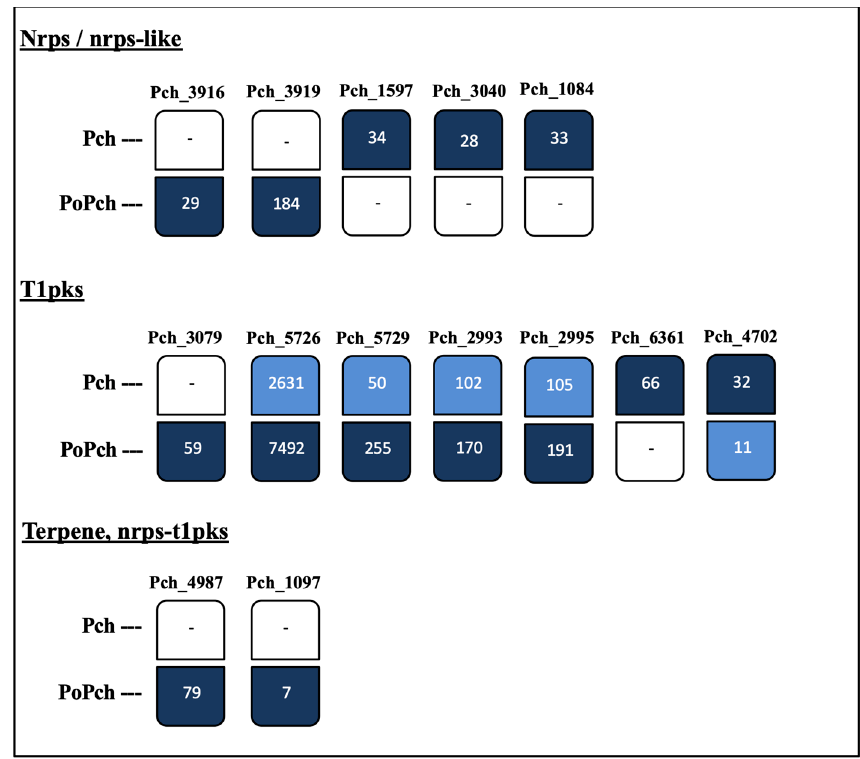
Figure 7. Expression level of Phaeomoniella chlamydospora genes predicted as secondary metabolites producers obtained in the RNAseq experiment. Expression level values are given as FPKM (fragments per kilobase per million mapped fragments). nrps = non-ribosomal peptide synthetase; t1pks = type 1 polyketide synthase. Pch: P. chlamydospora ; PoPch: Pythium oligandrum and P. chlamydospora . Light blue means that the number of transcripts is lower than in the other treatment. Dark blue means the number of transcripts is higher than in the other treatment. Blank means no transcripts detected in the samples. Table 1. CAZymes genes predicted in the Phaeomoniella chlamydospora genome and transcripts detected in the RNAseq samples. Within parentheses: the number of genes related to CAZymes that could be potentially secreted (SignalP positive). Pch: P. chlamydospora ; PoPch: P. oligandrum and P. chlamydospora . Number of Genes Detected in Samples Number of Genes Families Predicted in the Genome Pch PoPch Glycoside hydrolases (GH) 345 (72) 60 (17) 70 (9) Glycosyl transferases (GT) 268 (17) 34 (3) 69 (7) Carbohydrate-binding module (CBM) 141 (26) 27 (6) 37 (4) Carbohydrate esterases (CE) 107 (12) 13 (1) 10 (3) Auxiliary Activities (AA) 56 (14) Polysaccharide Lyases